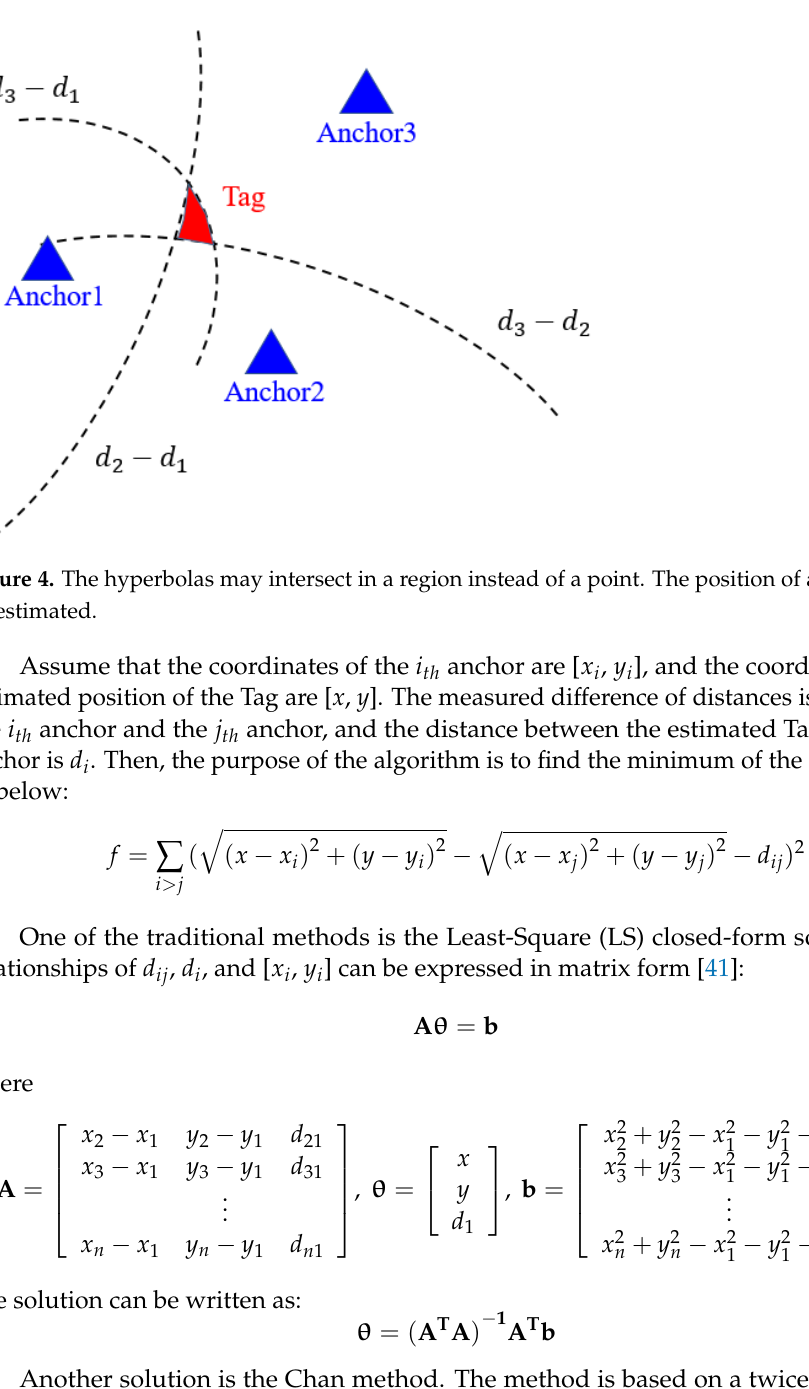
( b ) Figure 3. ( a ) The modified TWR between the Center and anchors. ( b ) TDOA with anchor synchronization. 4.2. TDOA Positioning Algorithms With the synchronized timestamp differences of the Center and Anchors, the differ-